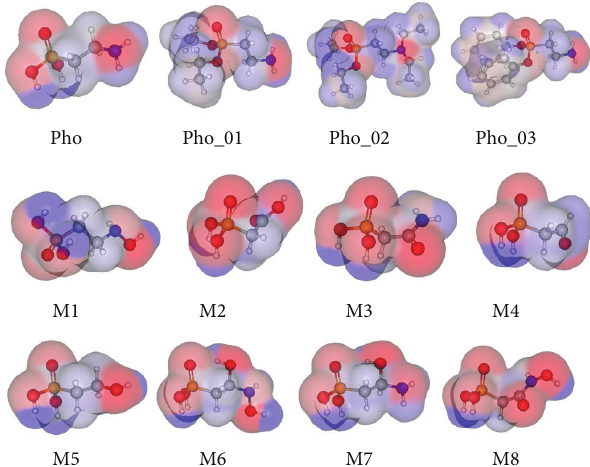
Table 3: Combine binding energy values in MolDock score of